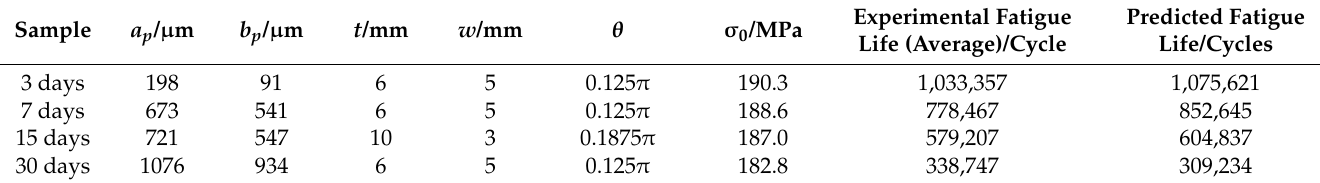
Table 4. Parameters of the fatigue life prediction model for the 5083/6005A welded joints.